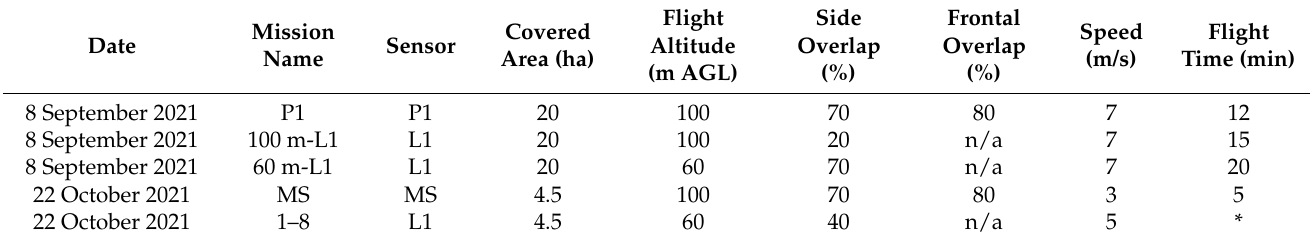
Table 1. Summary of flight configurations for the missions executed for this work.